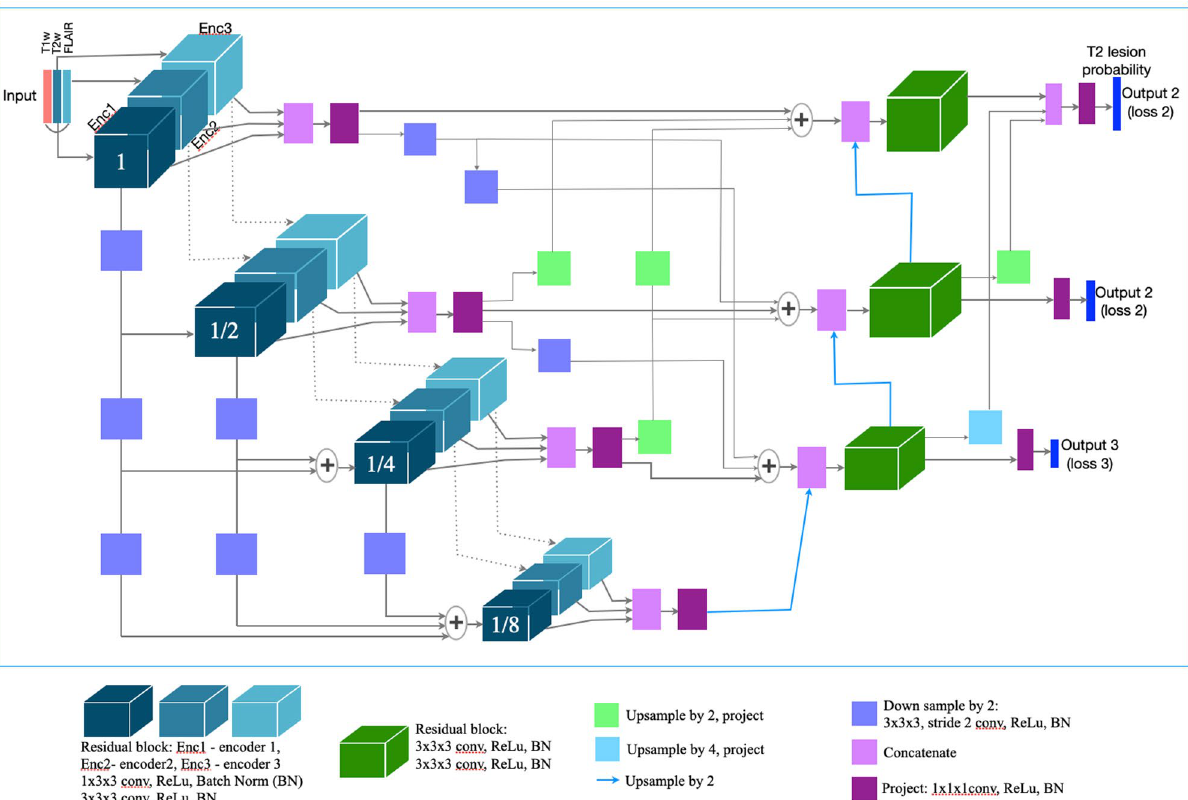
Figure 1. Network architecture of multi-arm U-Net for MS T2 lesion segmentation. The network uses three encoders: Encoders 2 and 3 capture the disjoint lesion information in FLAIR and T2w MRI,